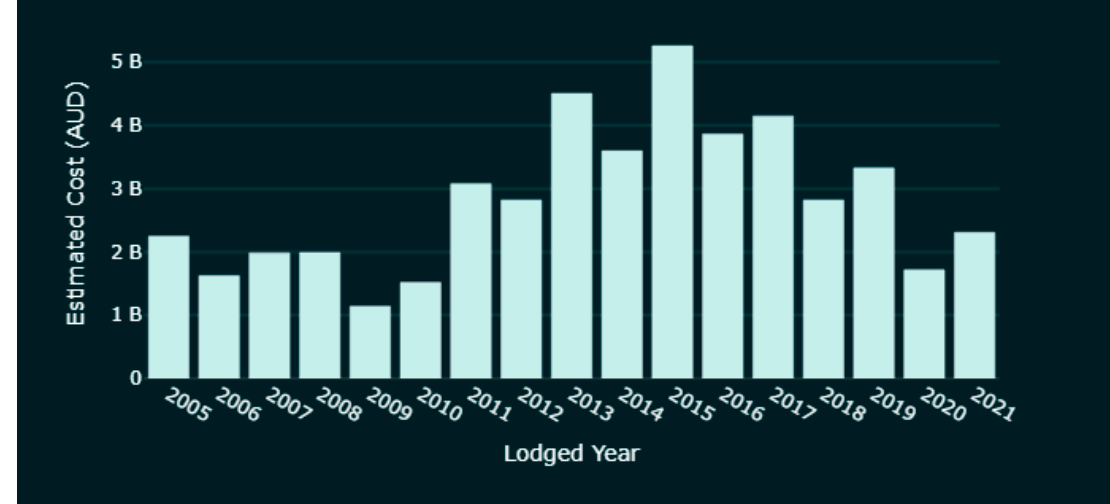
Figure 24. Total estimated cost of determined DAs by lodgement year (2005–2021).